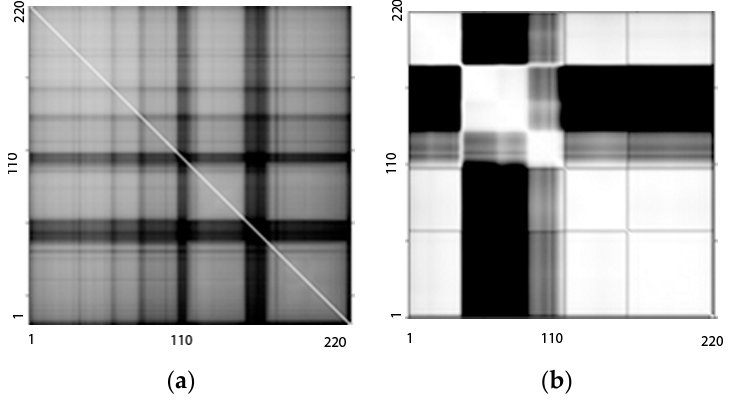
Figure 3. Spectral band-to-band measurement used for segmentation of the Indian Pines HSI: ( a ) NMI matrix in the image and ( b ) the correlation matrix in image form. Table 1. Band grouping information of the Indian Pines (AVIRIS) HSI.